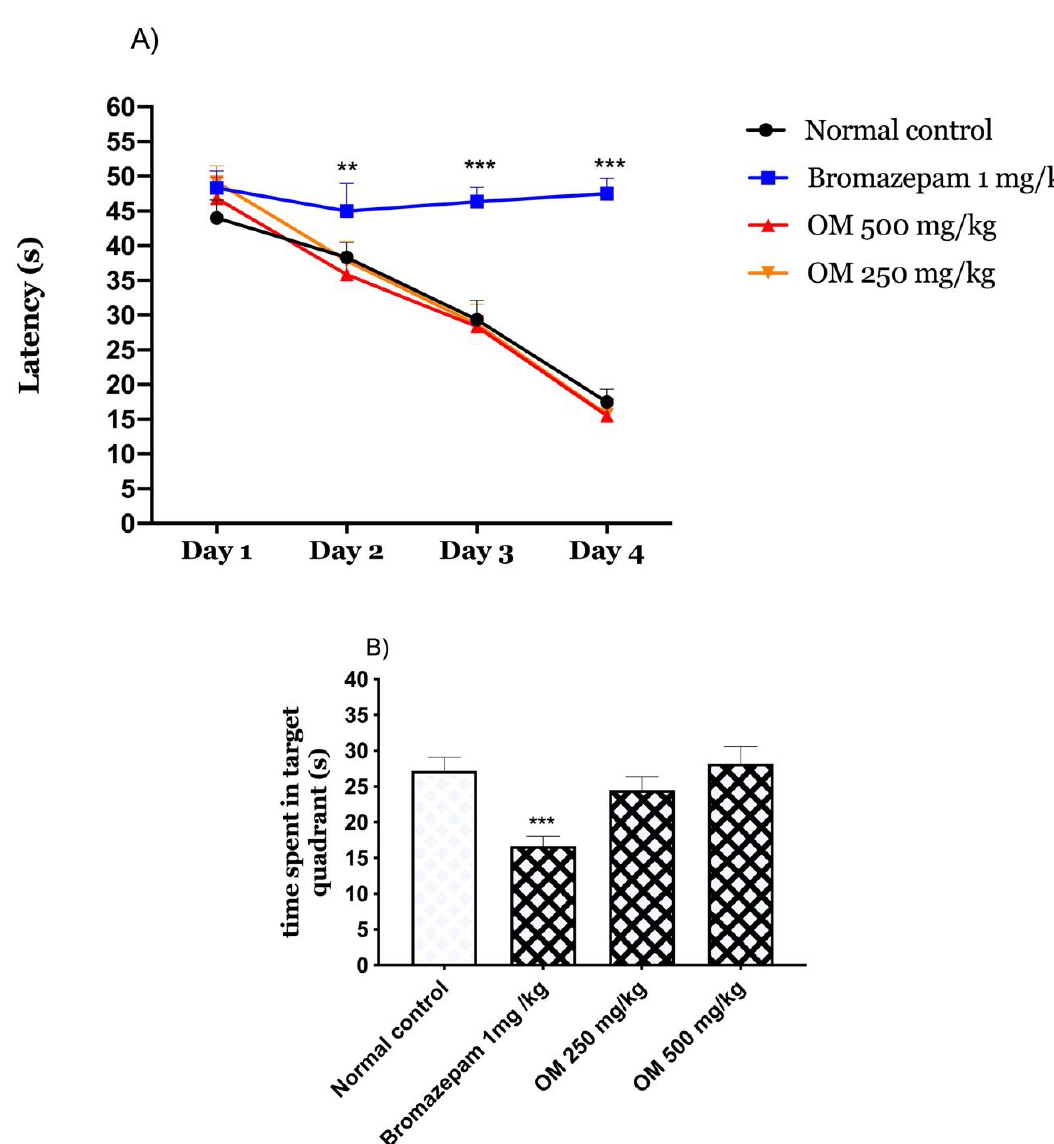
Figure 5. Effects of OM in the Morris water maze test. ( A ) latency time, ( B ) time spent in the target quadrant. Values are expressed as mean ± SEM. The analysis was done using two-way repeated-measures analysis of variance followed by Dunnett post hoc test *** p < 0.001, ** p < 0.01 compared with normal control.